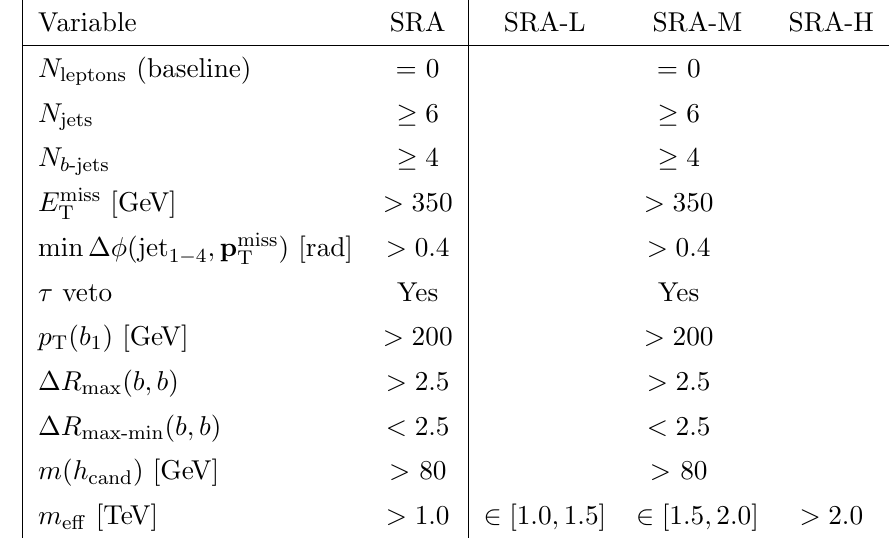
Table 1. De(cid:12)nitions for the SRA, alongside the three varying m appended to the SRA label corresponds to the low (-L), medium (-M) or high (-H) m e(cid:11) selection. This selection is sensitive to the bulk regions of both signal scenarios. The jets and b -jets are ordered by p T